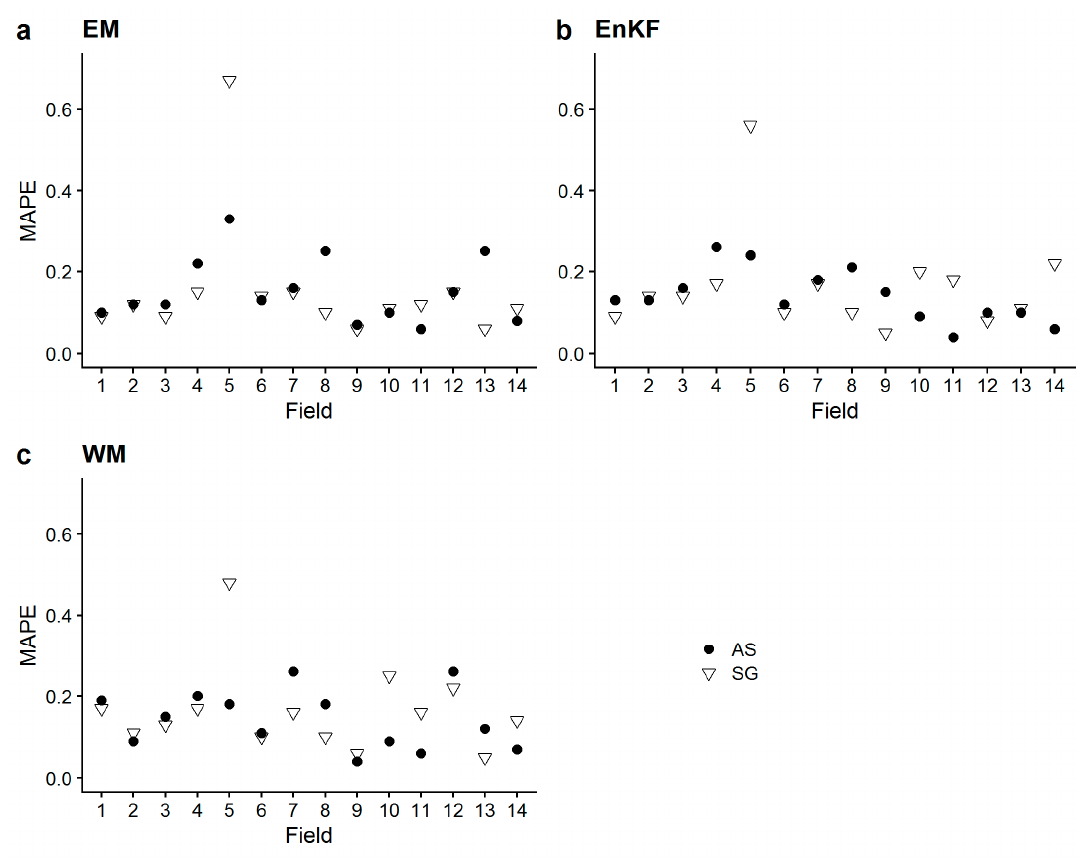
Figure 7. Mean absolute percentage error (MAPE, in decimal-%) calculated from measured vs. predicted biomass in all sampling points per field, for analyzed soil texture (AS) as model input and SoilGrids-extracted (SG) soil texture as model input. ( a ) Results for ensemble mean (EM); ( b ) results for ensemble Kalman filter (EnKF); ( c ) results for weighted mean (WM).